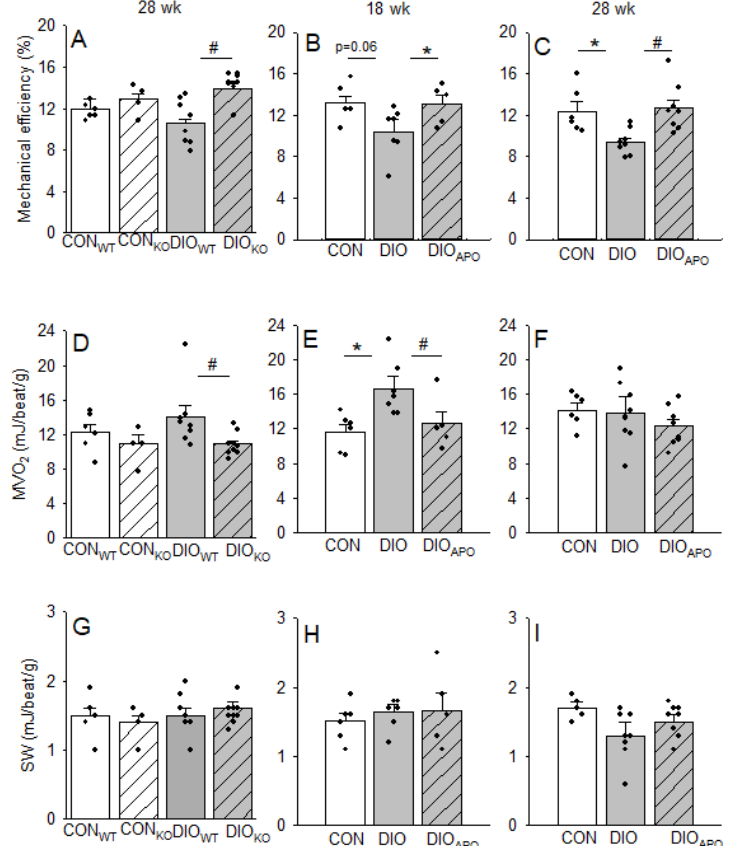
Figure 3. Left ventricular mechanical e ffi ciency ( A – C ) expressed as stroke-work (SW, G – I ) relative to myocardial oxygen consumption ( D – F ) in hearts from lean controls (CON WT and CON KO ) and diet-induced obese (DIO) wild type and NOX2 KO mice (DIO WT and DIO KO ) fed a high fat diet for 28 weeks ( A , D , G ) as well as lean controls (CON) and untreated and apocynin-treated obese C57BL / 6J mice (DIO and DIO APO ) fed a western diet for 18 weeks ( B , E , H ) or 28 weeks ( C , F , I ). Single values and means ± SEM. * p < 0.05 CON vs. DIO within same genotype, # p < 0.05 DIO WT vs. DIO KO and DIO vs. DIO APO .